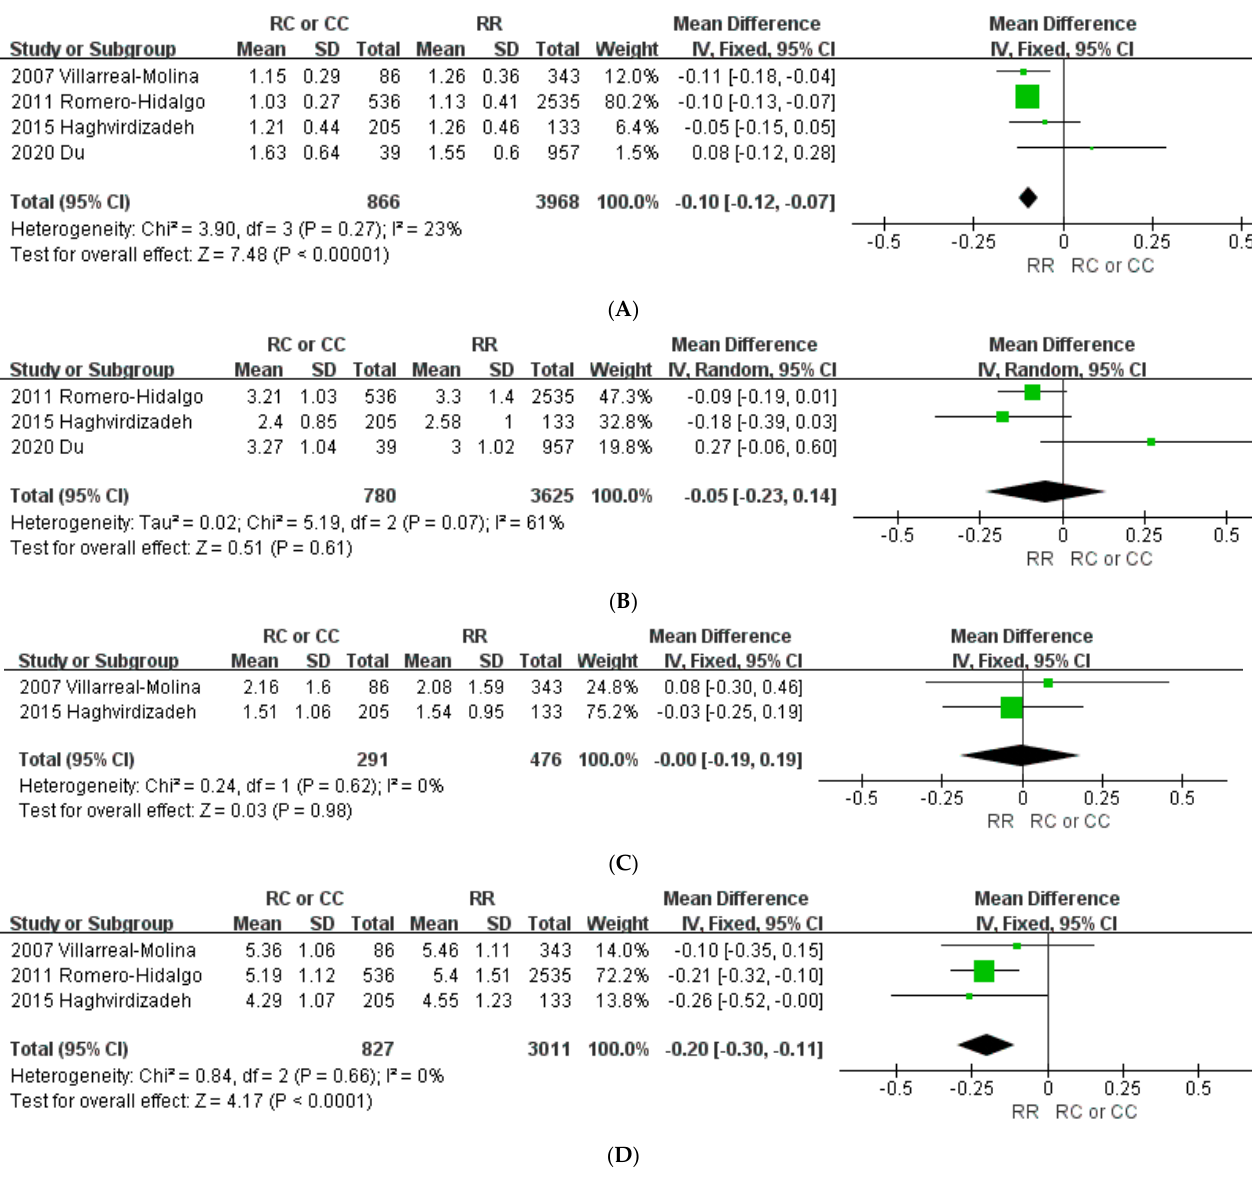
Figure 4. Forest plots demonstrating the association between the ABCA1 230R>C polymorphism and lipid level (mmol/L). ( A ) High-density lipoprotein cholesterol; ( B ) low-density lipoprotein cholesterol; ( C ) triglycerides; ( D ) total cholesterol.